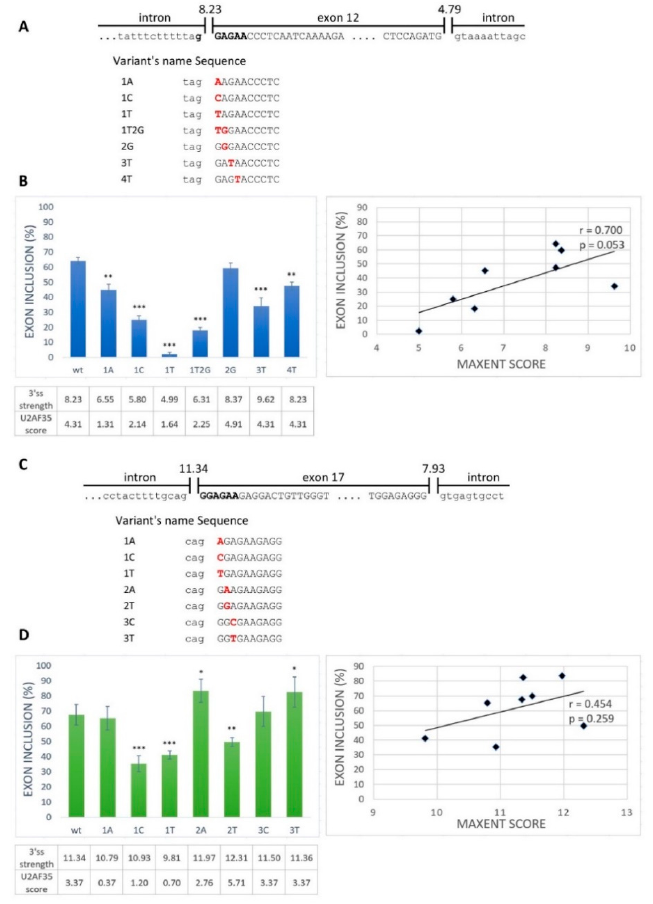
Figure 2. Splicing minigene assay to verify a potential ESE element. ( A , C ) Schematic representation